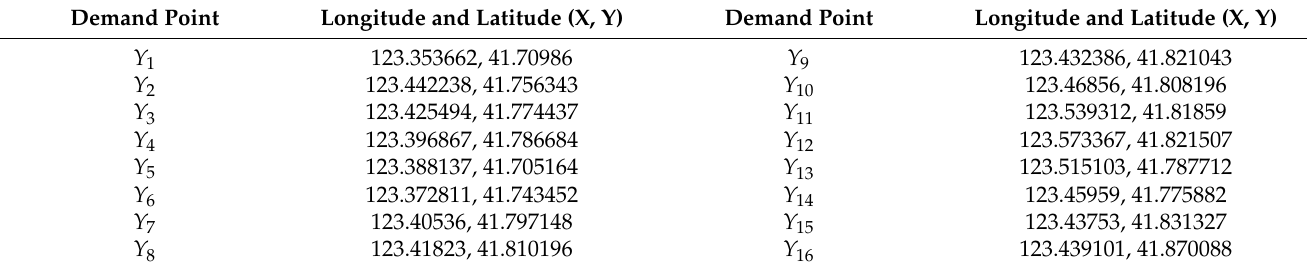
Table 8. Coordinates of demand points.